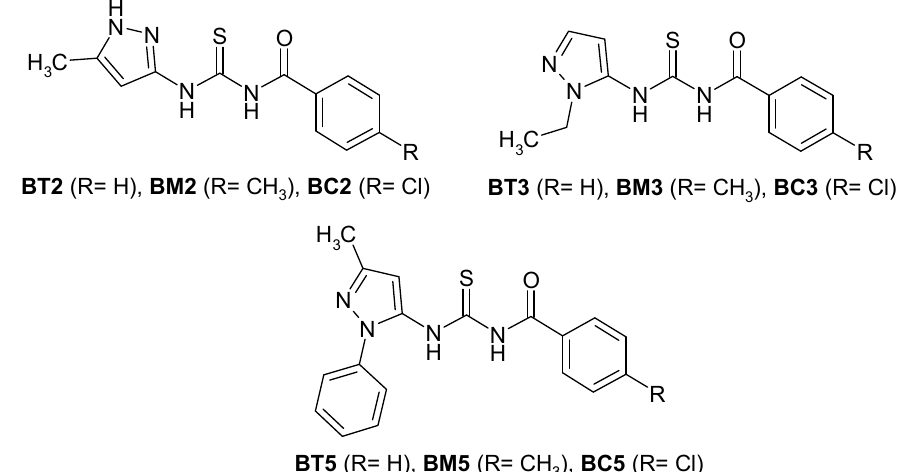
Figure 1. Chemical structure of the selected pyrazole